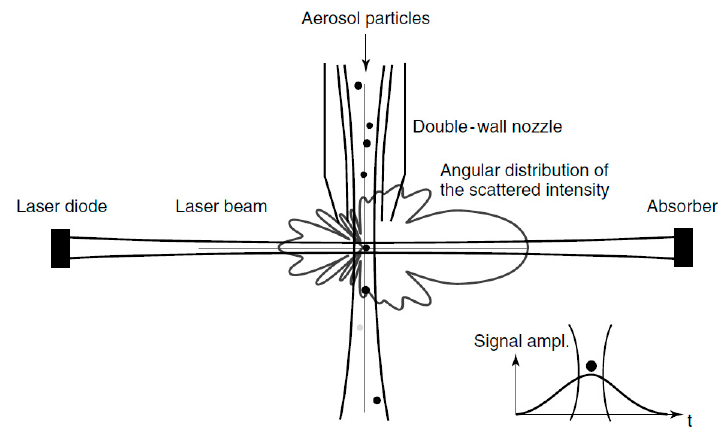
Figure 4. Generic scheme of an OPC: the particle crossing the illumination zone (viewing volume) generates a diffraction pattern at a 360° angle. The corresponding impulse recorded by the photodiode is shown in the inset; the intensity of the signal depends on the particle size, while its width is correlated to the viewing volume (image reprinted with permission of the authors in [59] provided by Wiley—VHC Publisher).